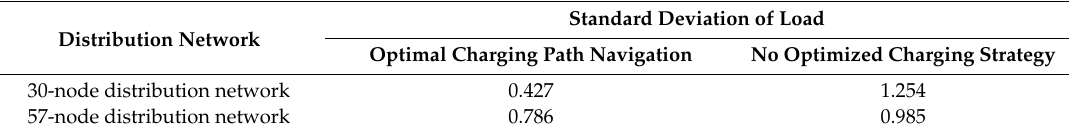
Table 5. Load standard